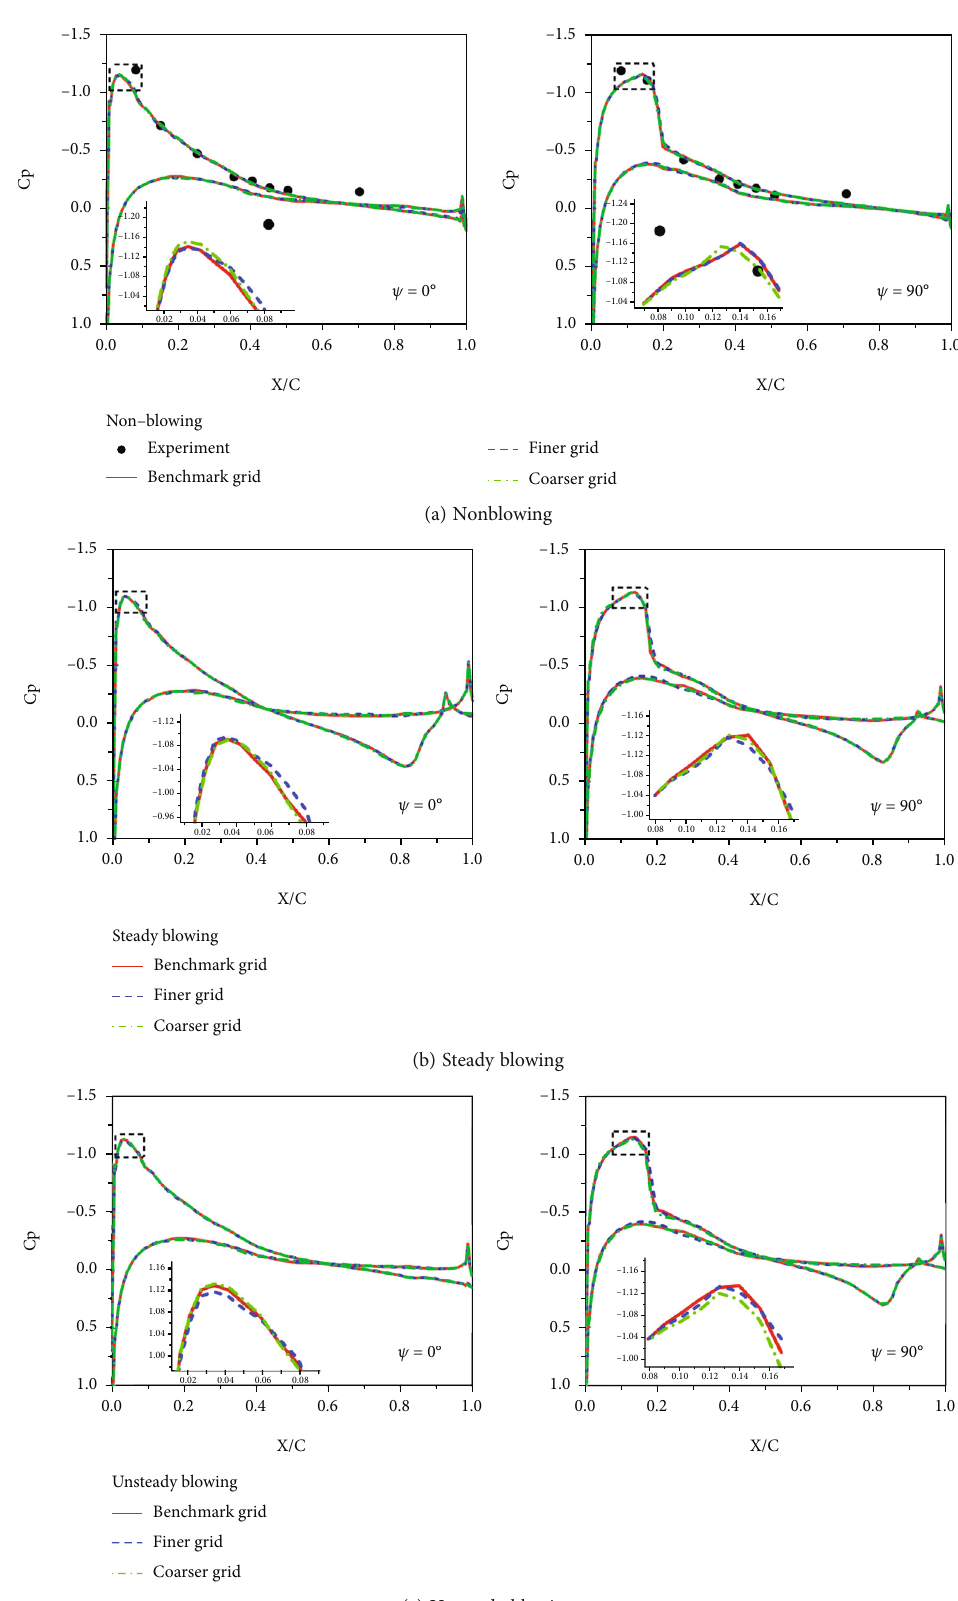
Figure 5: Blade surface pressure coe ffi cients ( r / R = 0 : 955 ) for the steady/unsteady blowing cases under the three background grid